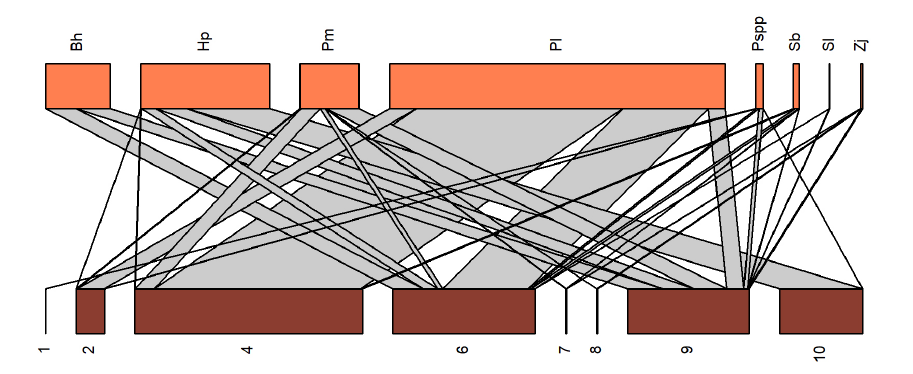
FIGURE 4 | Bipartite plot showing the relationship between the larval densities of the commercially valuable migratory fish species (in orange) and the sampling sites (in brown). The width of the bars is proportional to the number of interactions, that is, the abundance of larvae. The bands (gray) and lines (black) reflect the species-sites connections, with the broader bands representing greater larval densities, while the lines represent the interactions of the species with the sampling sites. Bh = Brycon hilarii ; Hp = Hemisorubim platyrhynchos ; Pm = Piaractus mesopotamicus ; Pl = Prochilodus lineatus ; Pspp = Pseudoplatystoma spp.; Sb = Salminus brasiliensis ; Sl = Sorubim lima ; Zj = Zungaro jahu ; Sites: 1 = Cabaçal River site 1; 2 = Cabaçal River site 2; FOR = Formoso River; 4 = Jauru River; 6 = Paraguay River; 7